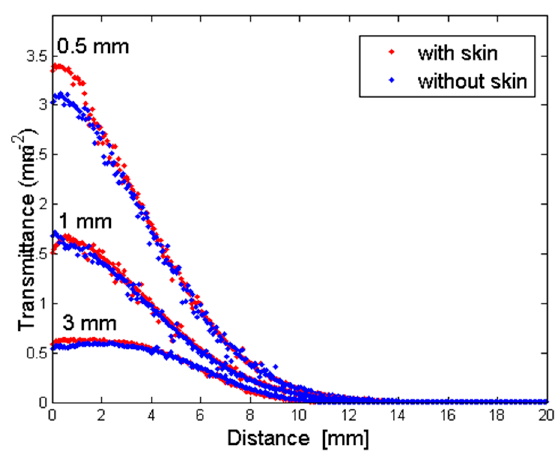
Figure 7. Effect of the source location on the reflectance profiles as measured on the equatorial plane of a half-cut Royal Gala, with and without skin and irradiated at 633 nm.